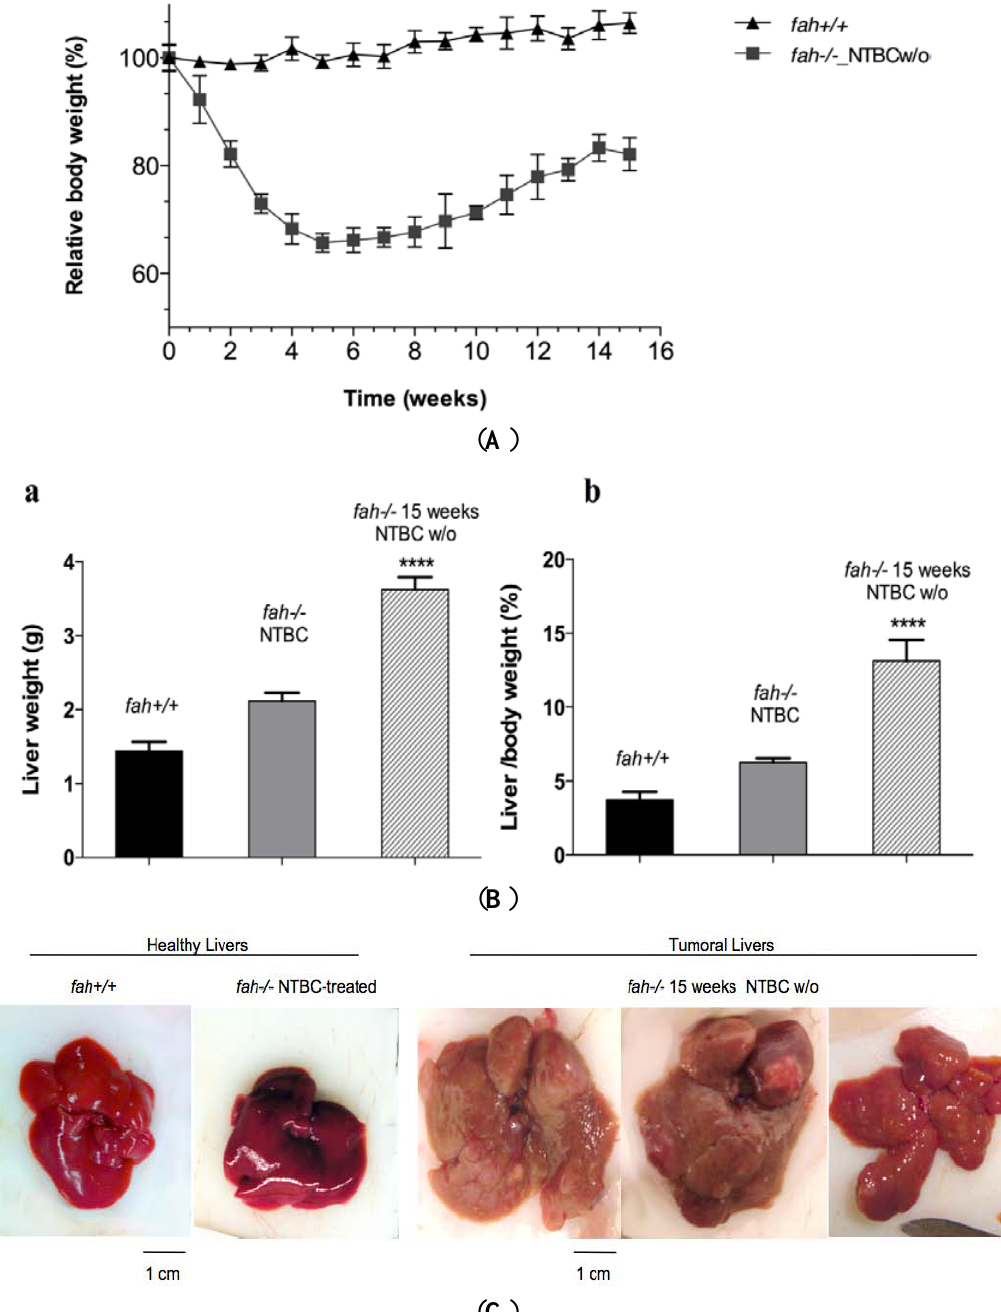
Figure 7. Changes in body mass values (%) of wt (▲) and fah −/− (■) mice following NTBC withdrawal. (A) Body weight curves of fah +/+ (▲), and fah −/− NTBC w/o (■) mice. Each time point indicates the average of four mice, with error bars indicating standard deviation. Unpaired t-test (Welch’s correction) was applied for statistical validation of the two groups ( p value < 0.0001 for all the time point). ( B ) Liver weight ( a ), and liver /body weight ratios ( b ), of fah +/+ , fah −/− NTBC-treated mice and fah −/− mice following 15 weeks of withdrawal ( n = 4, **** p < 0.0001, ANOVA variance analysis). ( C ) Representative pictures of whole healthy livers and tumoral livers. The images were taken at the beginning of the procedure (control mice) and after 15 weeks of withdrawal from